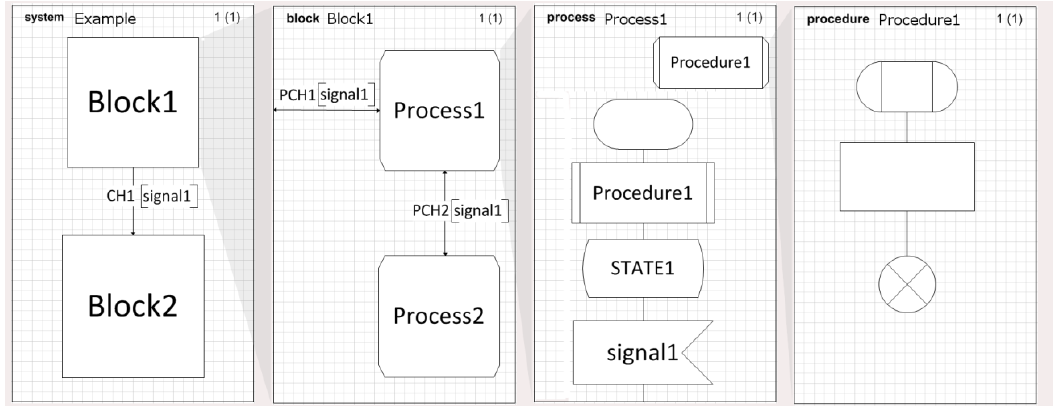
Figure 4. Specification and Description Language (SDL) modular decomposition.